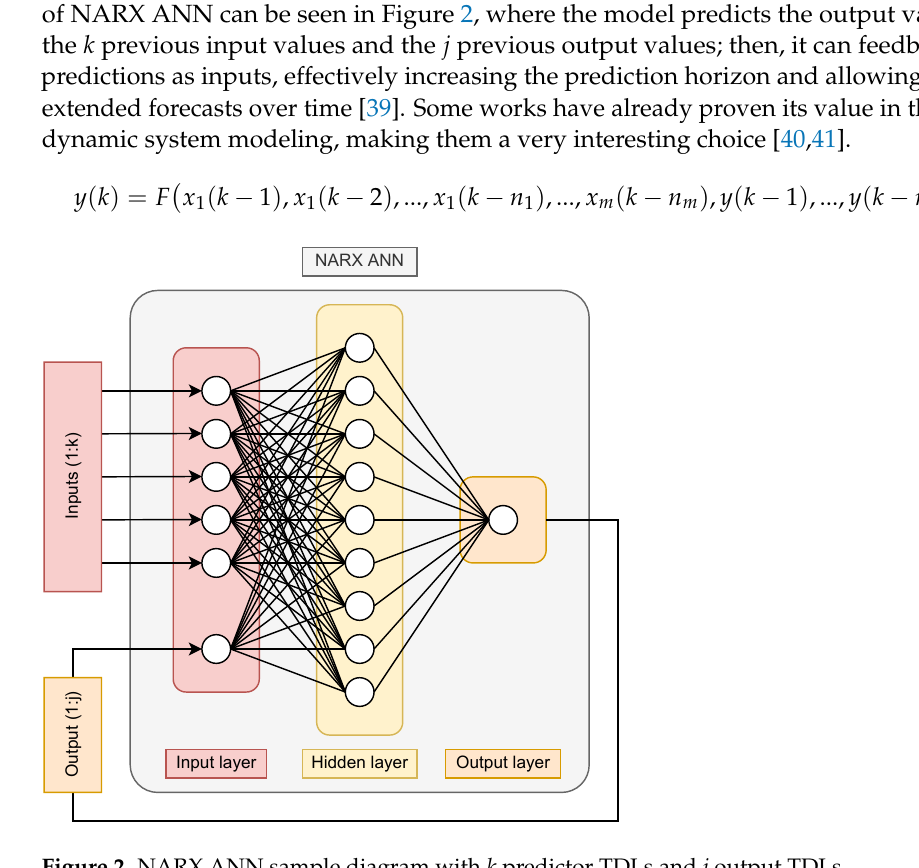
Figure 2. NARX ANN sample diagram with k predictor TDLs and j output